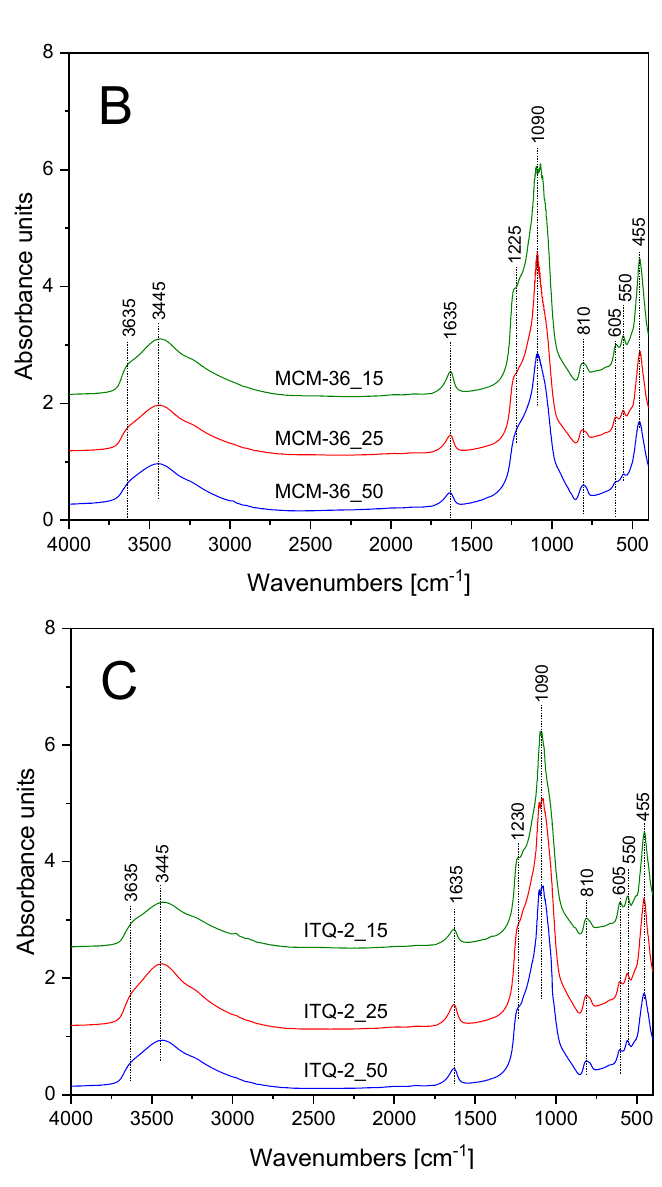
Figure 2. FT-IR spectra of MCM-22 ( A ), MCM-36 ( B ), and ITQ-2 ( C ) zeolites. Table 2. Assignments of FT-IR bands in the spectra of zeolitic